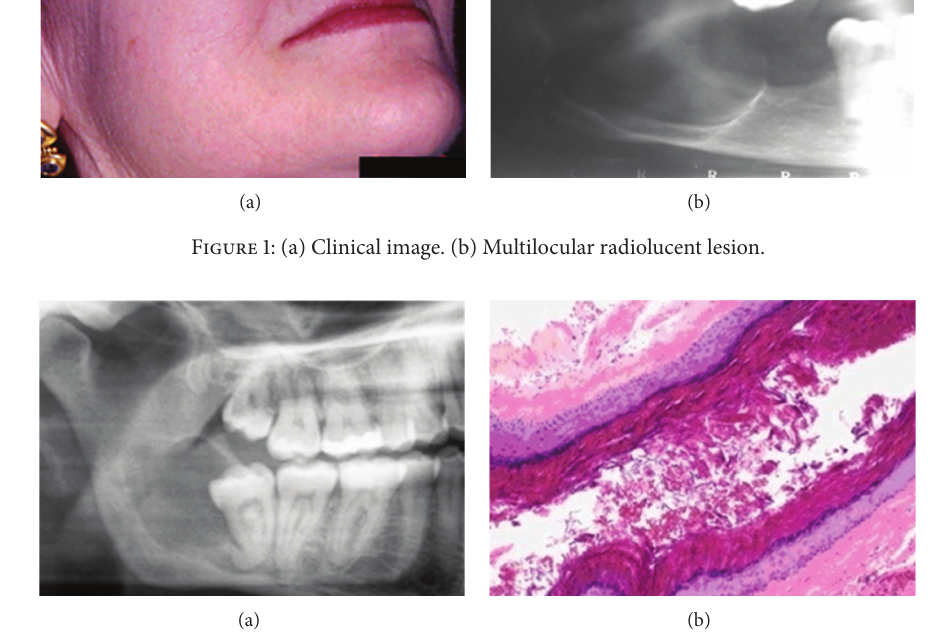
0 and 2% of cases which is in marked contrast with the 40% recurrence of KCOT [2, 11,